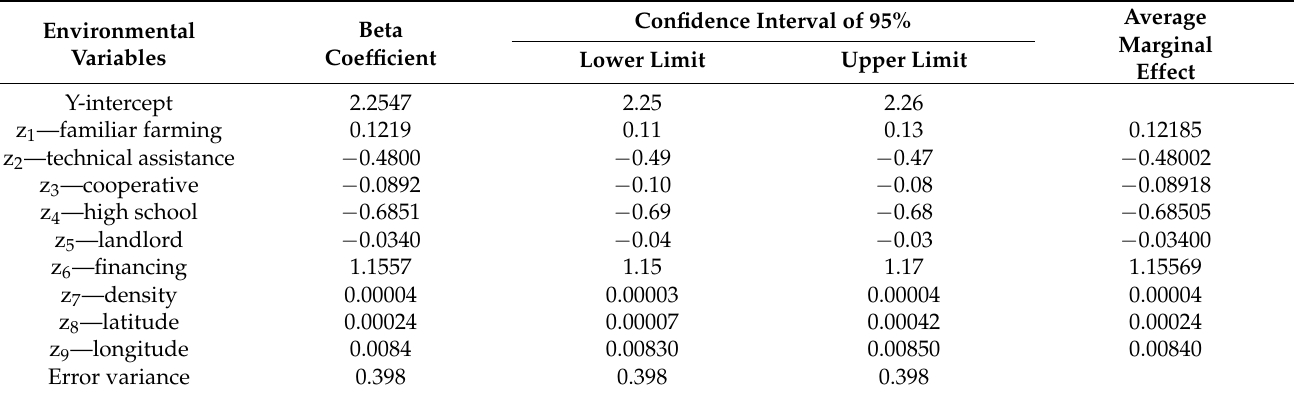
Table 3. Results of the model applied to second-stage